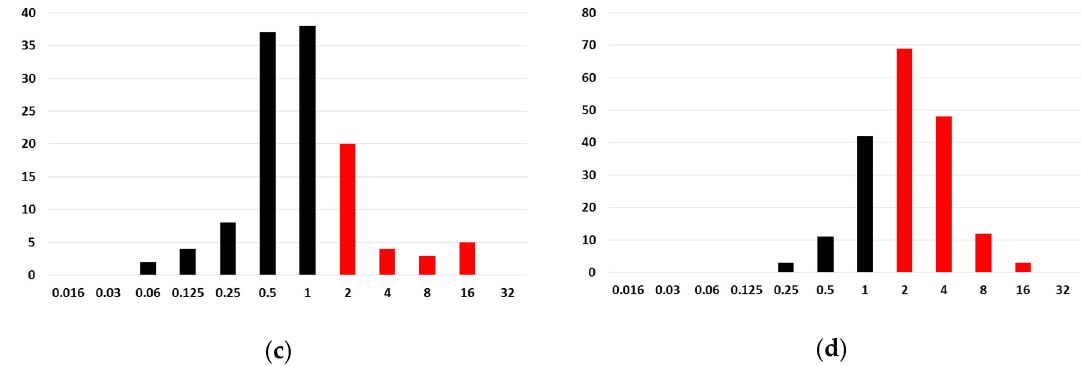
Figure 2. Minimum inhibitory concentration (MIC) distributions of amphotericin B against ( a ) A. fumigatus , ( b ) A. flavus , ( c ) A. nidulans , and ( d ) A. terreus . Columns depicted in red and black represent MICs in the area of resistance and susceptibility for A. fumigatus isolates, respectively. Data extracted from the amphotericin B rational document v2.0 (https: // www.eucast.org / asto ff ungi / Table 2. ECOFFs and clinical breakpoints for itraconazole and posaconazole against Aspergillus spp. according to the EUCAST breakpoint table v 10.0, 2020 [33]. Itraconazole (mg /